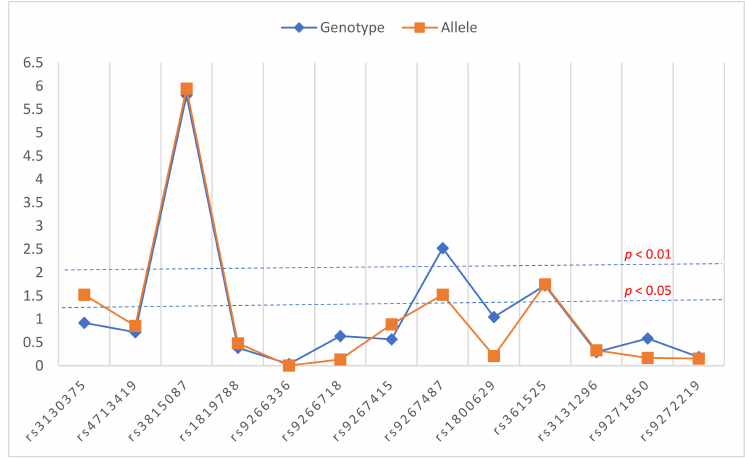
Figure 1. Association of SNPs in MHC region with schizophrenia. X-axis shows the polymorphisms screened and Y-axis shows the p values for each polymorphism on a logarithmic